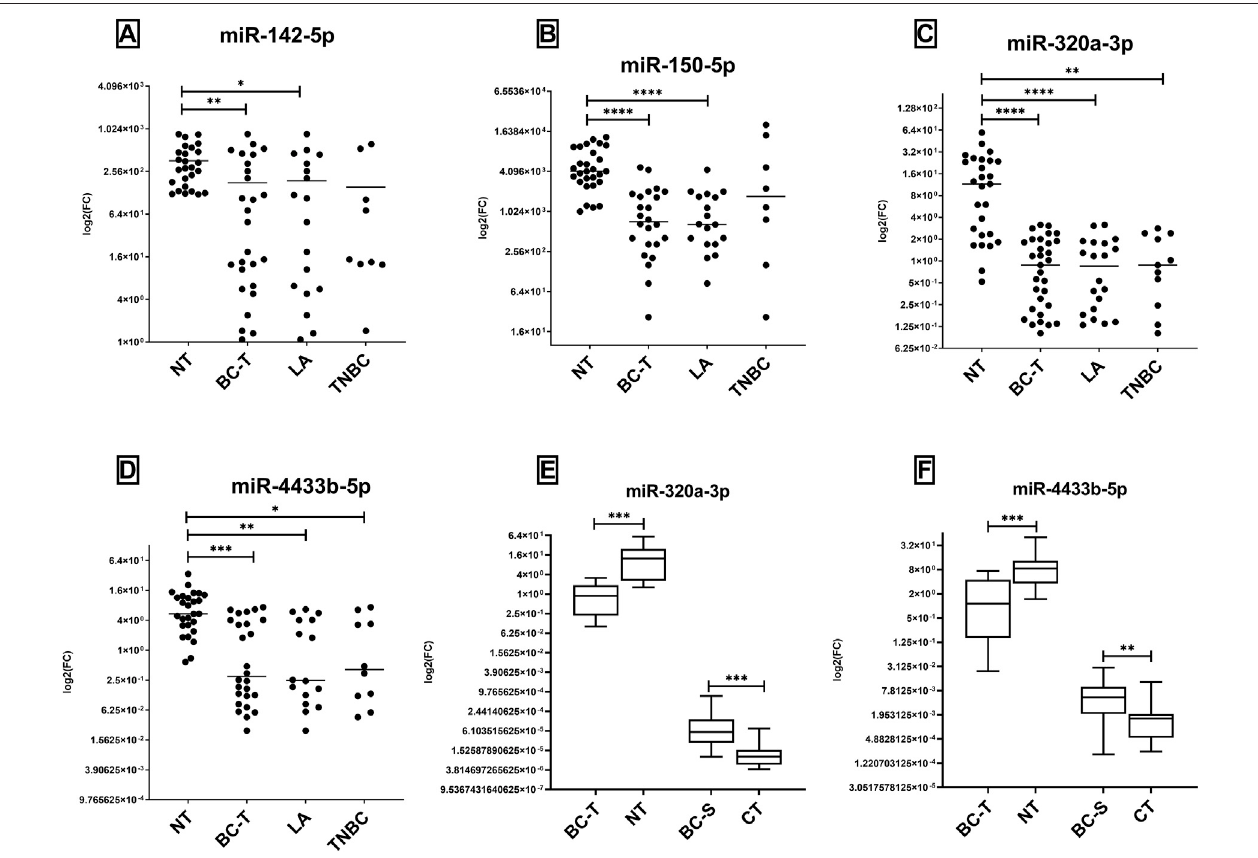
FIGURE 2 | Expression levels of miR-142-5p, miR-150-5p, miR-320a, and miR-4433b-5p on fresh tissue samples. miR-142-5p, miR-150-5p, miR-320a, and miR-4433b-5p evaluated by RT-qPCR in tissue samples (A – D) , and the comparison between serum and tissue expression in matched samples (E,F) . (A – D) Levels of expression were evaluated in NT and BC-T samples; BC-T samples comprised LA and TNBC subtypes, and the expression of all miRNAs was evaluated. After outlier removal,eachdotrepresentsonesampleinthetissuegroup.NTsamplesshowedoverexpressionofallmiRNAsevaluatedcomparedtoBC-T (A) andLAsamples. (E,F) BC-S and BC-T were evaluated as matched pairs from patients with both samples to all miRNAs ( n = 16). NT and CT were also compared but not paired. Inverse directions were found between miRNA expression comparing BC-S (high) and BC-T (low). BC-T, breast cancer tissue samples; NT, non-tumor samples; BC-S, breast cancer serum samples; LA, luminal A; TNBC, triple-negative breast cancer; and CT, controls. (*) p = 0.01; (**) p = 0.001; (***) p = 0.0001; and (****) p <